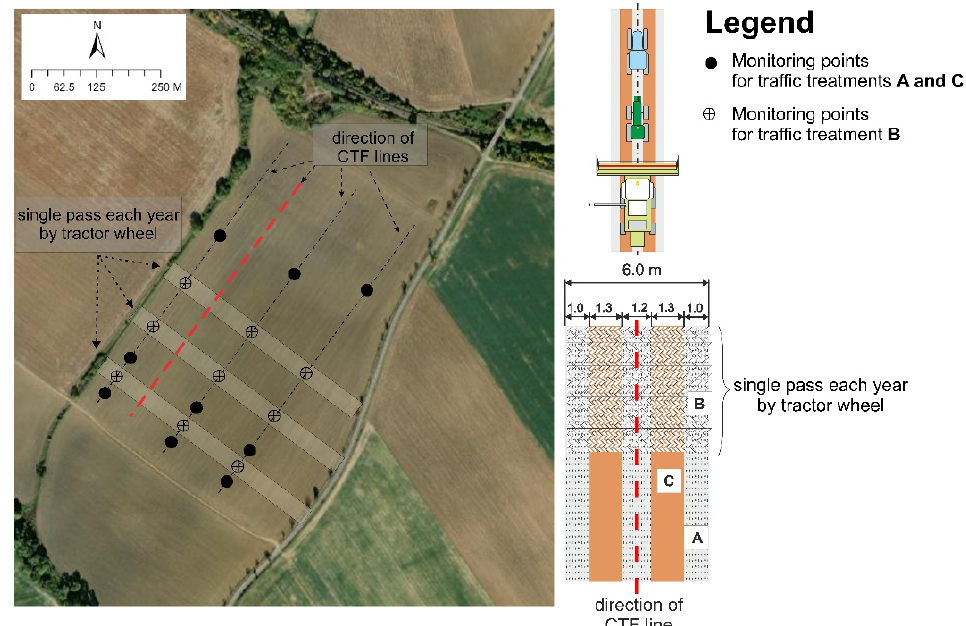
Figure 1. Experimental field showing the direction of the permanent tramlines and the three traffic intensity areas: (A) no traffic area; (B) single pass area; (C) multiple pass/permanent tramline area. For sampling and data collection, these refer to A, B, and C areas, where: